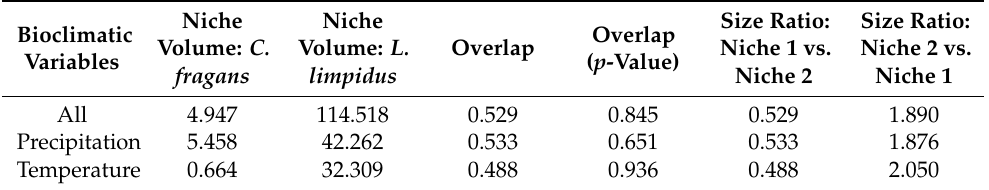
Table 3. Analysis of ellipsoidal niche overlap based on environmental conditions relevant for Lepturges limpidus and Catostemma fragrans . Size Ratio: Size Ratio: Niche Niche Overlap Bioclimatic Niche 2 vs. Niche 1 vs. Volume: L. Overlap Volume: C. ( p -Value) Variables limpidus fragans Niche 1 Niche 2 All 4.947 114.518 0.529 0.845 0.529 1.890 Precipitation 5.458 42.262 0.533 0.651 0.533 1.876 Temperature 0.664 32.309 0.488 0.936 0.488